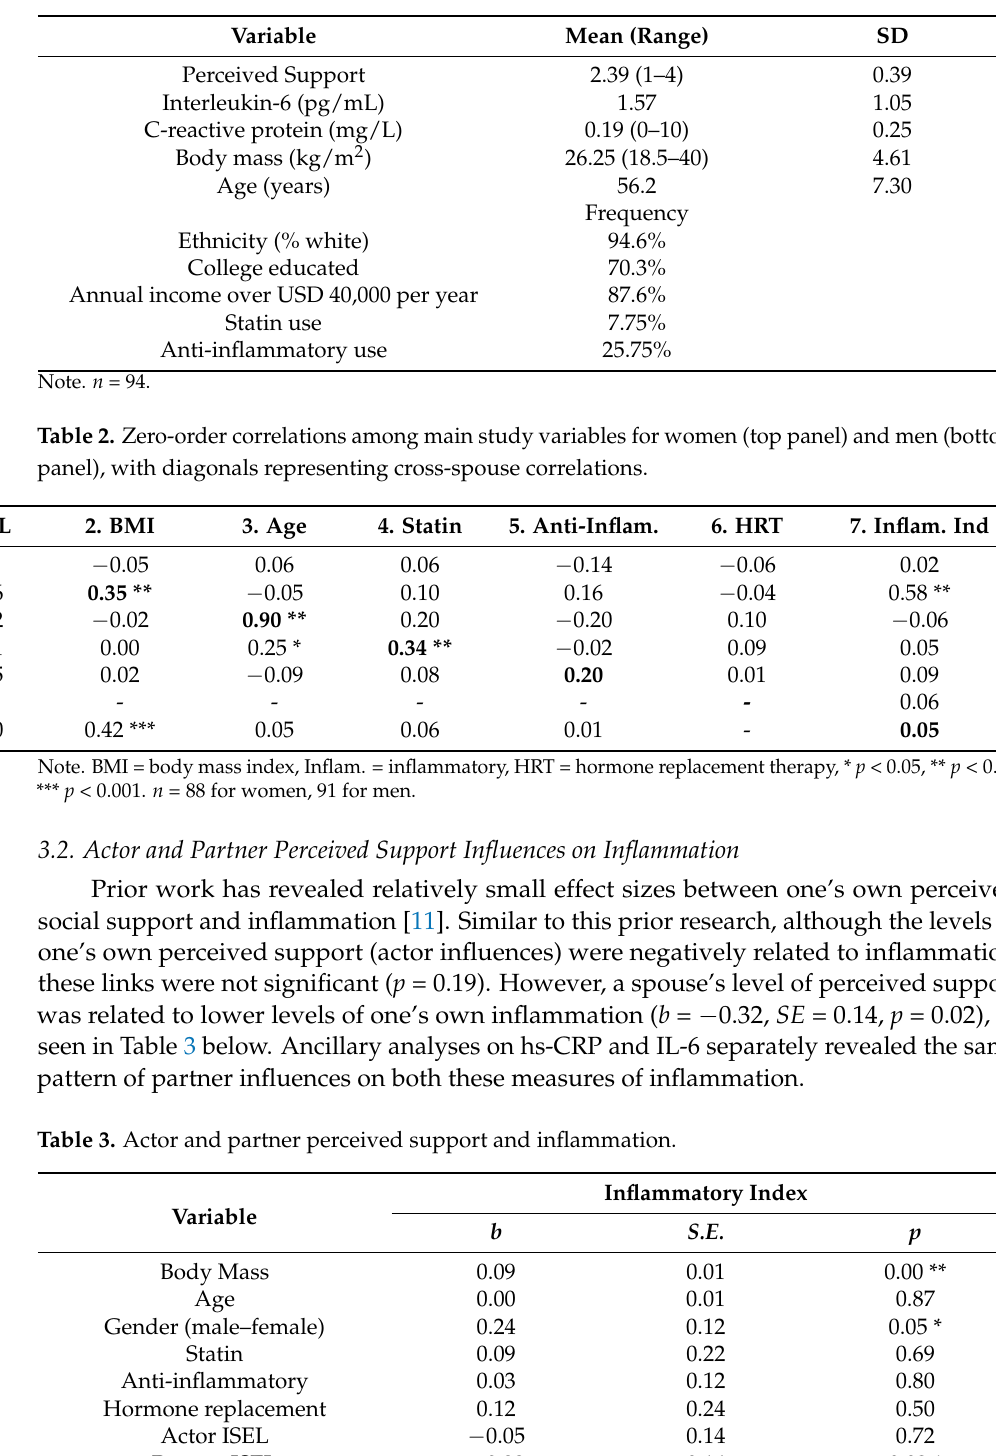
Table 1. Mean and standard deviation (SD) for main study variables.